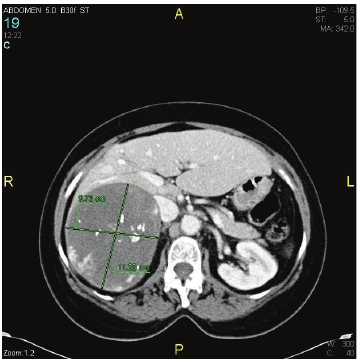
Figure 3: Complex right adrenal mass on MRI with no evidence of invasion.